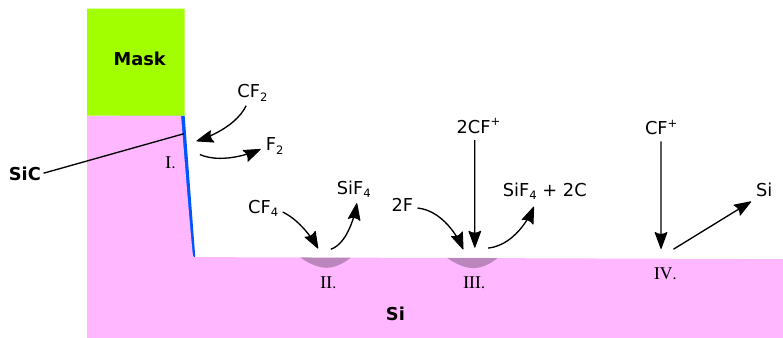
Figure 13. Active etching and deposition mechanics in CF type chemistries used to etch poly-Si: I. chemical deposition of carbon forming an SiC passivation layer, II. chemical etching, III. ion-enhanced etching, and IV. ion sputtering through high energy